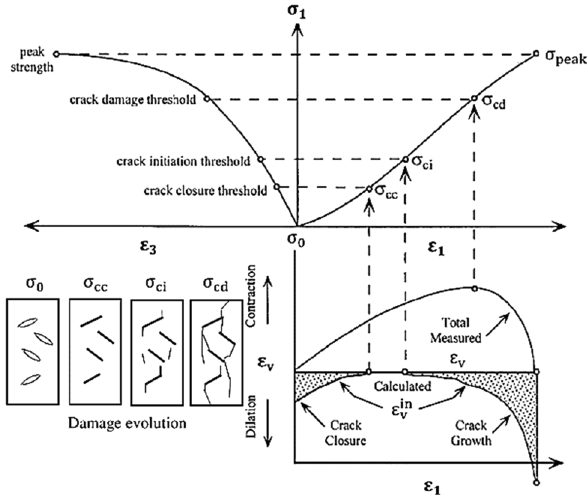
Fig. 3 Tangent modulus curve of Gasford sandstone showing bending at the applied stress